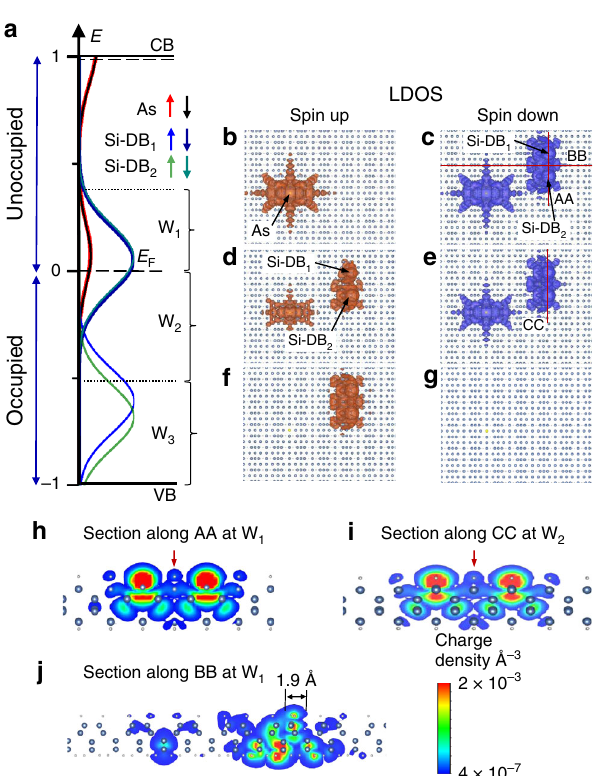
Fig. 3 Calculated spatial distributions of charge for a Si-DB // . a PDOS curves at the two Si-DB // and the As atom (recall from Fig. 2) for three selected energy windows W 1 – W 3 . b – g Spin-up (brown) and spin-down (blue) local density of state (LDOS) isosurfaces on the silicon slab for the three energy windows W 1 – W 3 . The chosen section of the slab is represented with blue and white balls as Si and H atoms, respectively. h – j Cross-sectional plot of the partial LDOS along the AA, BB, and CC axes de fi ned by the red lines in c and e At W ′ 2 (Fig. 4e), the occupied part of the Si-DB spin-down LDOS is slightly asymmetric revealing the small degeneracy lift of the empty PDOS peaks of the Si-DB ⊥ states. The STM topographies